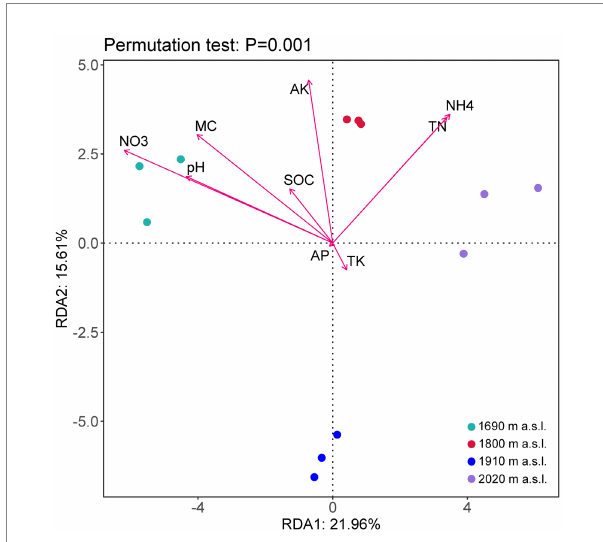
FIGURE 4 Redundancy analysis (RDA) of soil fungal community structures and environmental characteristics (arrows) at different